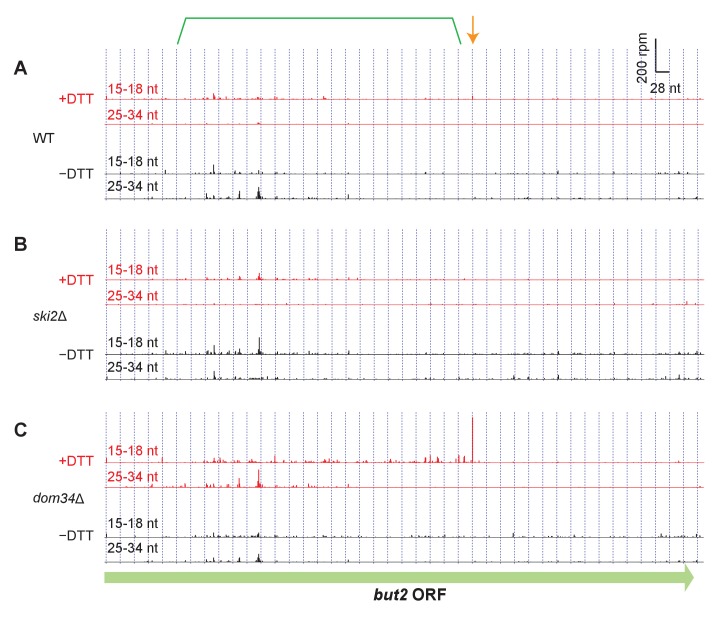
Read alignment to an example gene in different strain backgrounds. (A–C) Same as Fig. Figure 3B but showing additional datasets for but2. For reference, annotation of the original stall site and upstream NGD cleavage in Figure 3B have been retained.